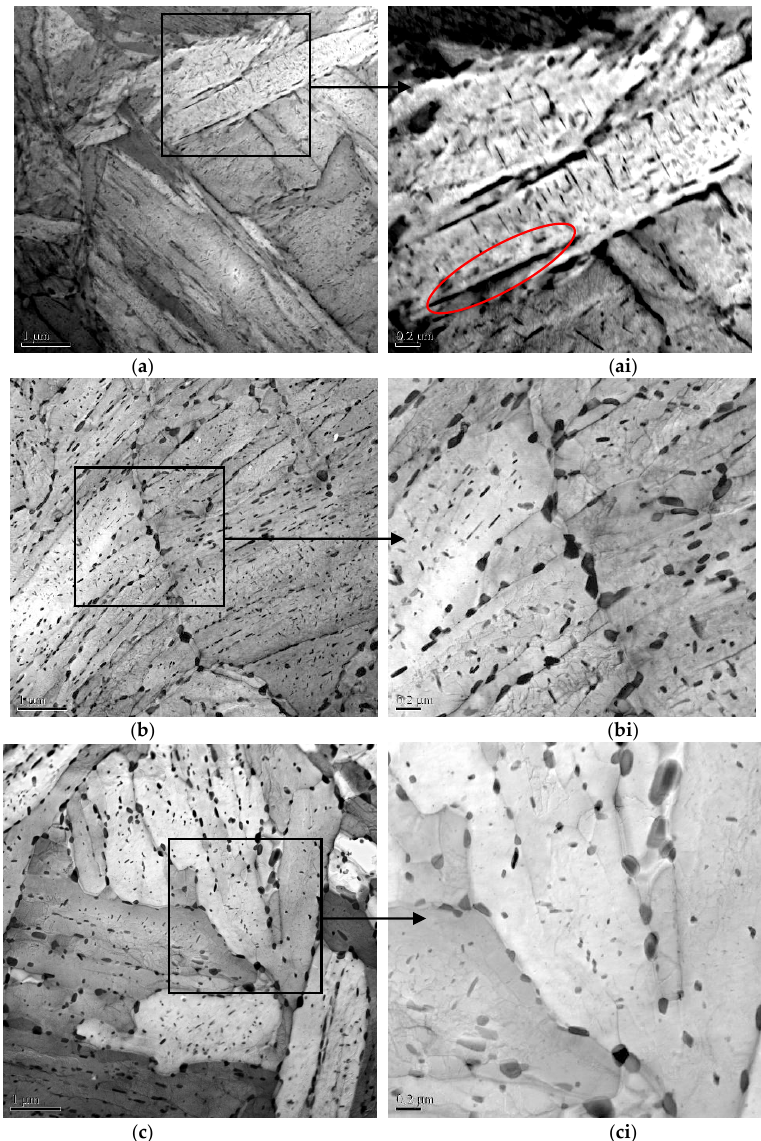
Figure 9. Typical TEM observations of martensite lath and precipitate in Q&T–treated samples at differing T t of ( a ) 650; ( b ) 700; and ( c ) 720 ◦ C and their enlarged micrographs ( ai , bi and ci ). The red frame showing the rod-like precipitated particles distributed in the martensitic laths